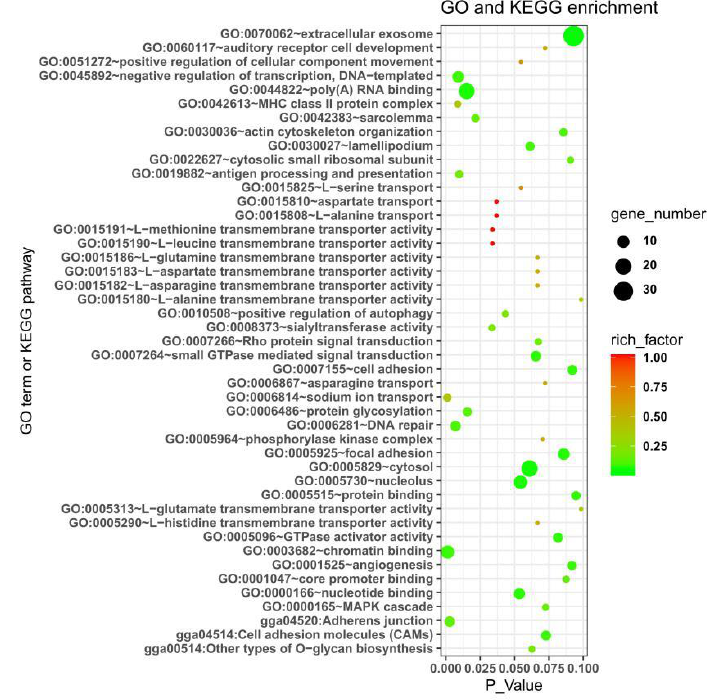
Figure 5. GO and KEGG enrichments with differentially expressed genes between the hearts of the Tibet chicken embryo and the lowland chicken embryo in a simulated hypoxic hatchibator with 13% oxygen concentration at the end of day 16 of incubation.